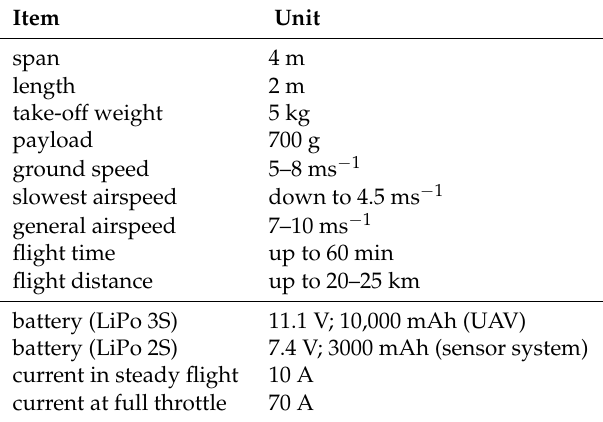
Table A3. Technical details of the fixed-wing